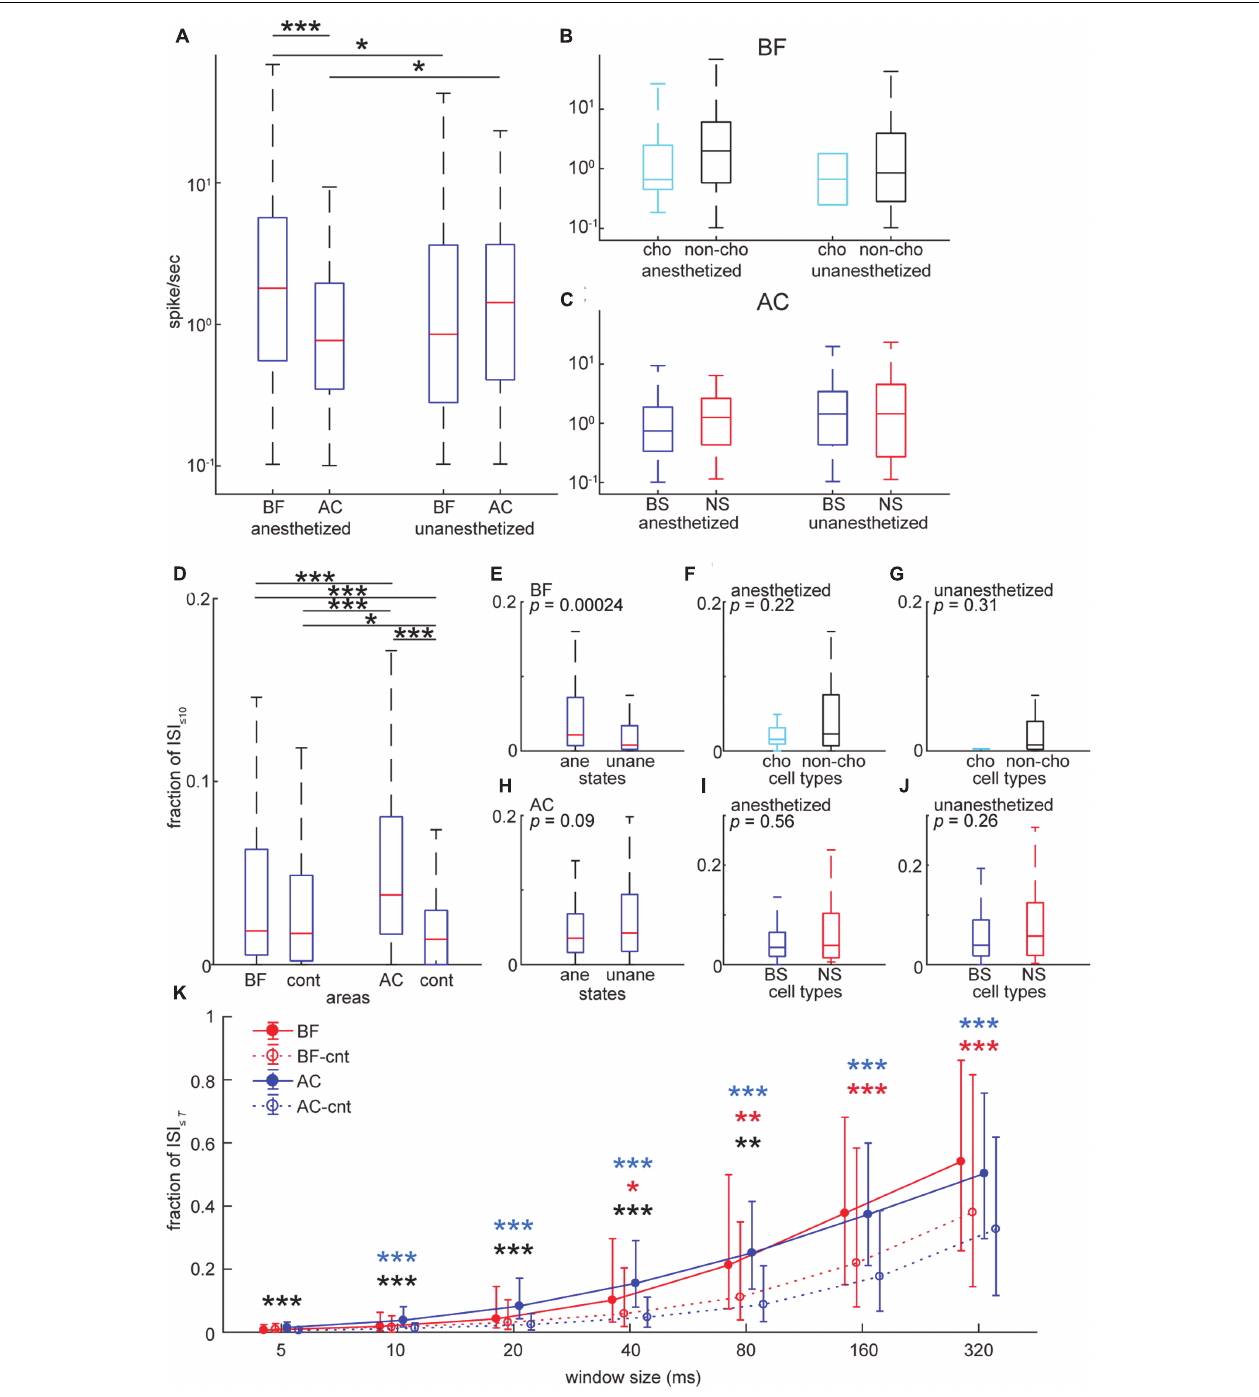
FIGURE 4 | Comparison of spontaneous firing rate and inter-spike intervals in the BF and AC at the single cell level. (A) Comparison of average spontaneous firing rate between the BF and AC in log scale. The effect of brain area was significant ( F 1 , 706 = 6.31, p = 0.012) whereas the effect between anesthetized and non-anesthetized conditions was not significant ( F 1 , 706 = 0.045, p = 0.83). The interaction of brain area and state was significant ( F 1 , 706 = 15.1, p = 1.08e–04). ∗∗∗ p < 0.0001; ∗ p < 0.05 [ post hoc honest significant difference (HSD) test]. (B) Comparisons of average spontaneous firing rate between cholinergic (cho) and non-cholinergic (non-cho) neurons in the BF. The effect of cell type ( F 1 , 353 = 1.15, p = 0.28) or state ( F 1 , 353 = 0.56, p = 0.45) was not significant. No significant interaction of cell type and state was observed ( F 1 , 353 = 0.029, p = 0.86). (C) Comparisons of average spontaneous firing rate between BS and NS cells in the AC. The effect of cell type ( F 1 , 349 = 0.22, p = 0.63) or state ( F 1 , 349 = 2.45, p = 0.11) was not significant. No significant interaction of cell type and state was observed